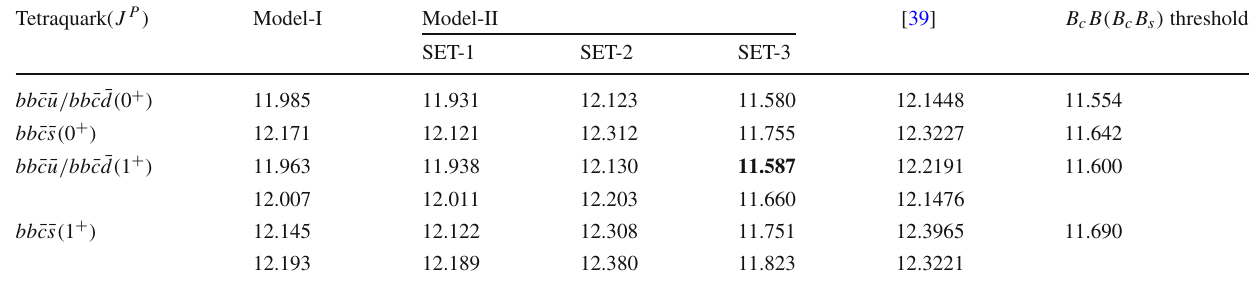
Table 1 The mass of tetraquark bb ¯ c ¯ q with J P = 0 + , 1 + from Model-I and Model-II in units in GeV. Particularly we use three schemes [64] for the calculation from Model-II, which are respectively SET-1 fitted from the mesons, SET-2 fitted from the baryons and SET-3 widely